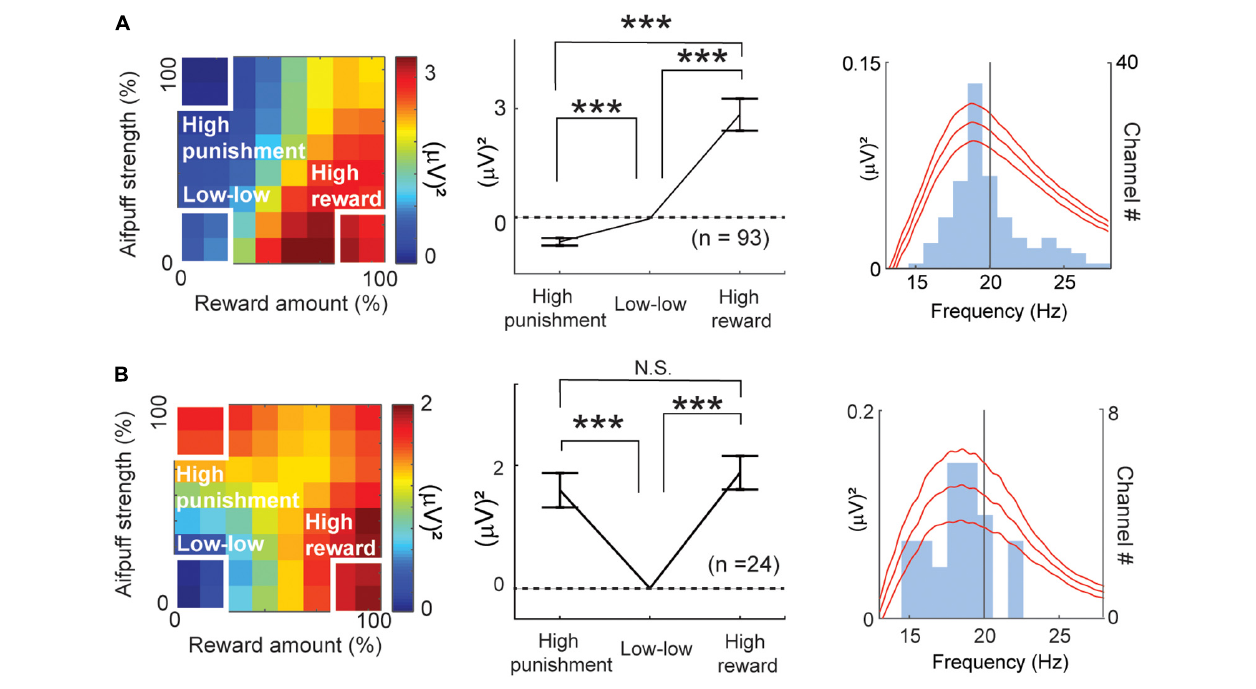
FIGURE 7 | Features of beta responses encoding valence and arousal. (A) Features of valence-encoding beta responses. The left panel shows the mean of the differential activity from the “low–low” condition for the valence-encoding beta responses. Activities of valence-encoding beta responses were mapped onto the decision matrix. Those of ChV( + ) beta responses were added, and those of ChV( − ) were subtracted. The middle panel shows the mean increase in activities from the “low-low” condition. The valence-encoding beta responses discriminated the “high-punishment” and “high-reward” conditions (Paired t -test, *** P < 0.001), showing differential responses to reward and punishment. The right panel shows the mean ( ± SEM) power spectra of the valence-encoding beta responses (baseline-subtracted), peaking at 18.7 Hz. The light blue histogram indicates the distribution of peaks of power spectra. (B) Features of arousal-encoding beta responses. The left panel shows the mean of the differential activity from the “low–low” condition for arousal-encoding beta responses. Activities of FOE( − ) beta responses were added, and those of FOE( + ) were subtracted. The middle panel shows the mean increase in activities from the “low–low” conditions. The activities in the “high-punishment” and “high-reward” were significantly higher than those in the “low–low” condition (Paired t -test, *** P < 0.001). The arousal-encoding beta responses did not discriminate the “high-punishment” and “high-reward” conditions (N.S.: P = 0.47 > 0.05). The right panel shows the mean ( ± SEM) power spectra of the arousal-encoding beta responses (baseline-subtracted), peaking at 18.9 Hz. The light blue histogram indicates the distribution of peaks of power